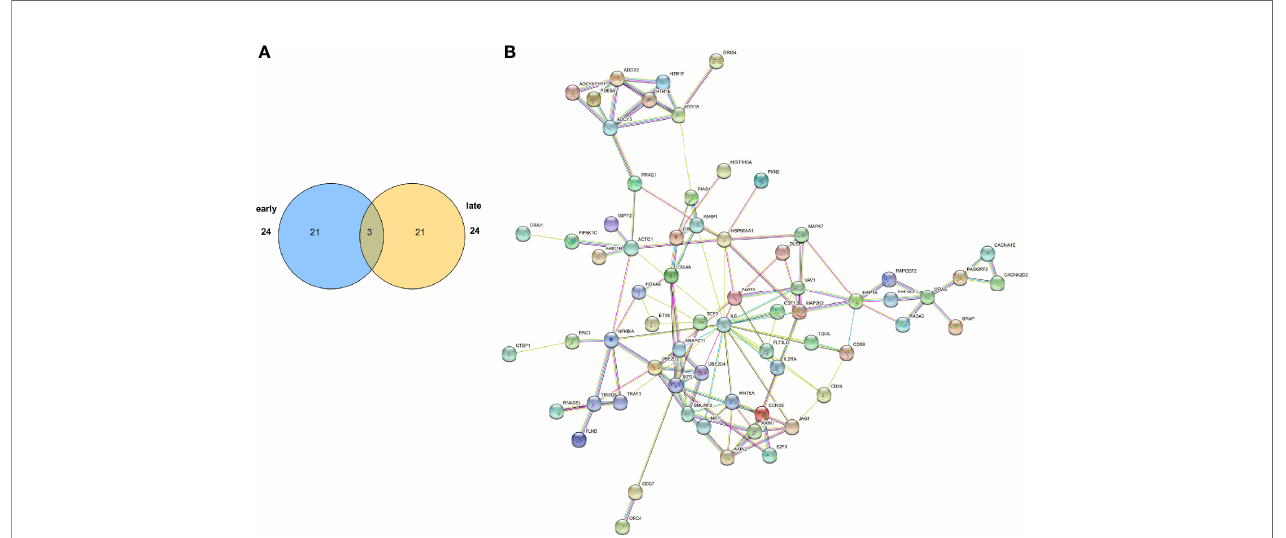
FIGURE 5 | Functional and network analysis of differentially abundant open chromatin peaks between the ES and LS groups. (A) Venn plot showing the number of pathways signi fi cantly enriched in the ES- or LS-speci fi c ATAC-seq peak-associated genes. (B) STRING network analysis of pathways enriched in the LS-speci fi c ATAC-seq peak-associated